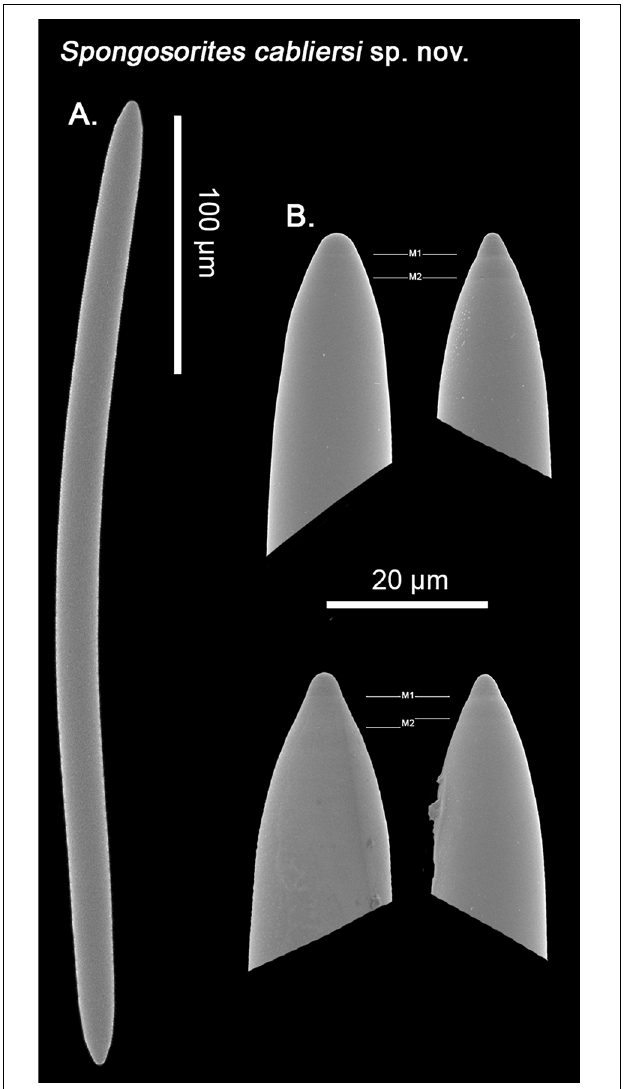
FIGURE 10 | SEM imagining of Spongosorites cabliersi sp. nov. spicular set. (A) General view of the strongyleoxeas. (B) Close up of the strongyleoxea’s heads, with a more or less mucronated end, preceded by more two tapering points (M1 and M2), which might be more or less marked between individual spicules. Scale bar for (A) 100 µ m; scale bar for (B) 20 µ